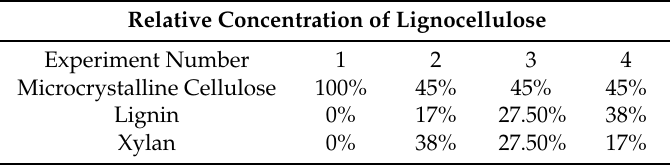
Table 1. Experimental conditions for regenerated films with a non-variable cellulose and variable lignin and xylan